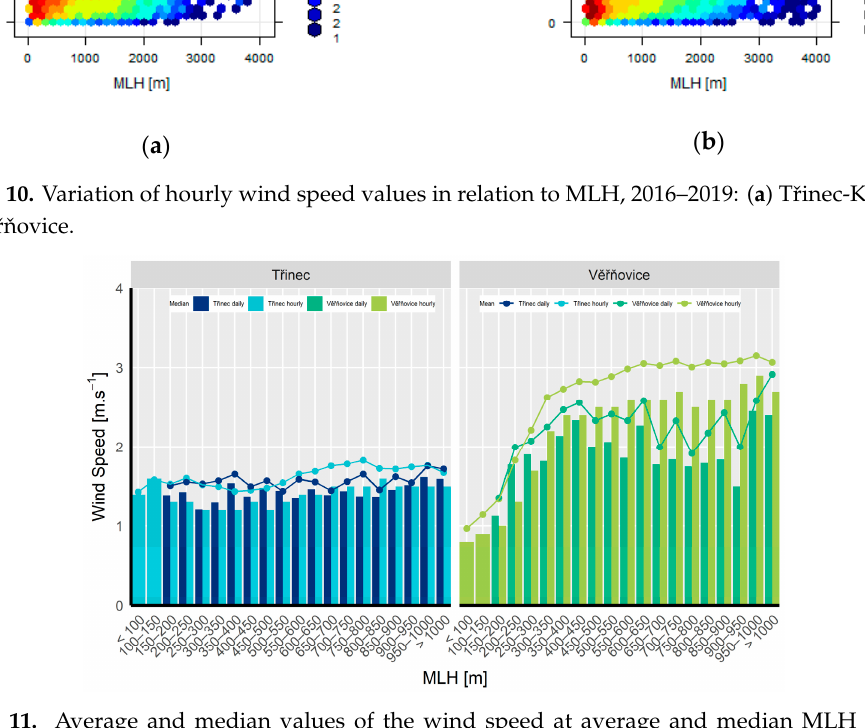
Figure 11. Average and median values of the wind speed at average and median MLH values, T ř inec-Kosmos, V ěřň ovice, 2016–2019.